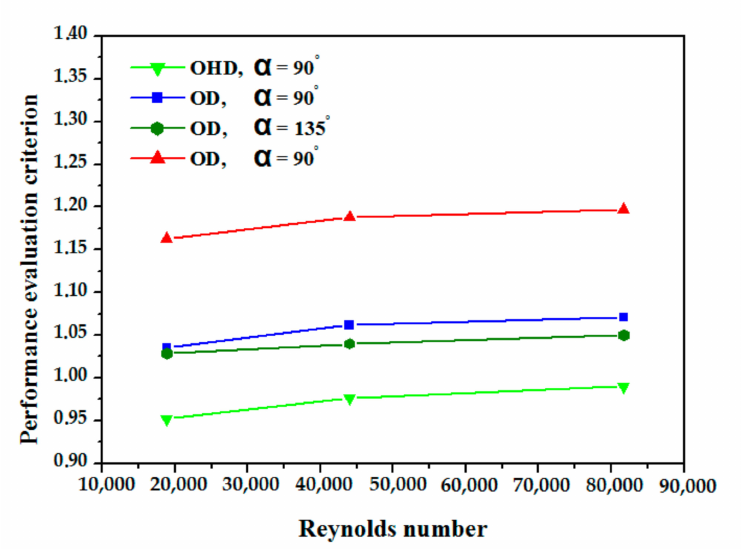
Figure 13. Performance evaluation criterion variation vs. Re number of the examined cases.